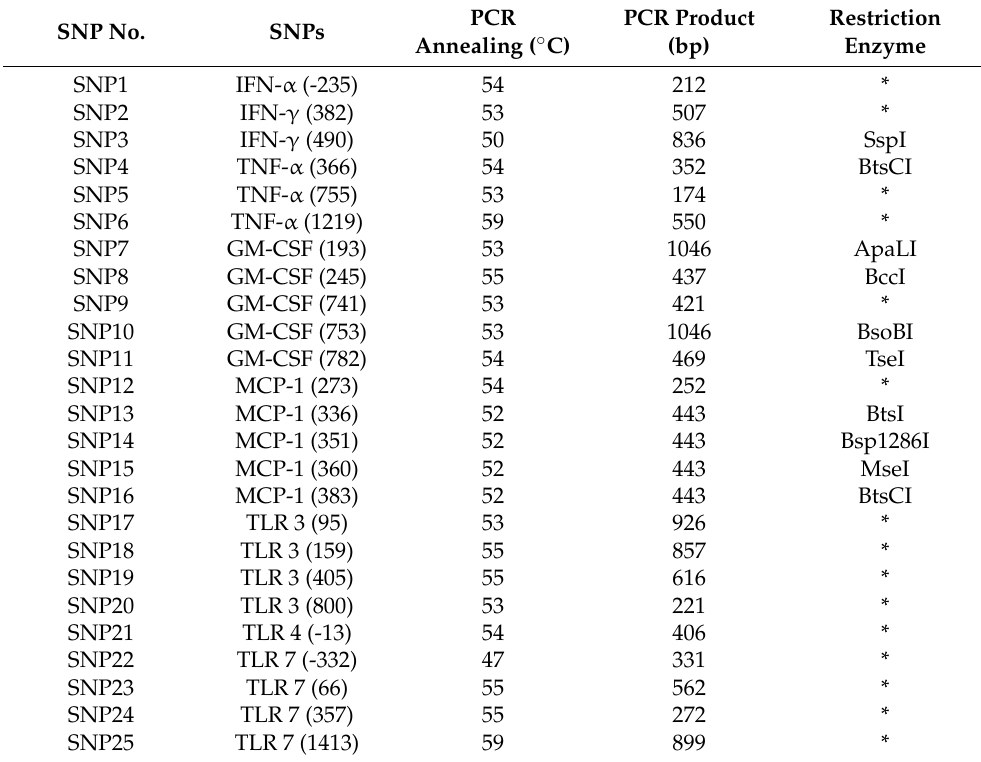
Table 1. The PCR analytic conditions and their